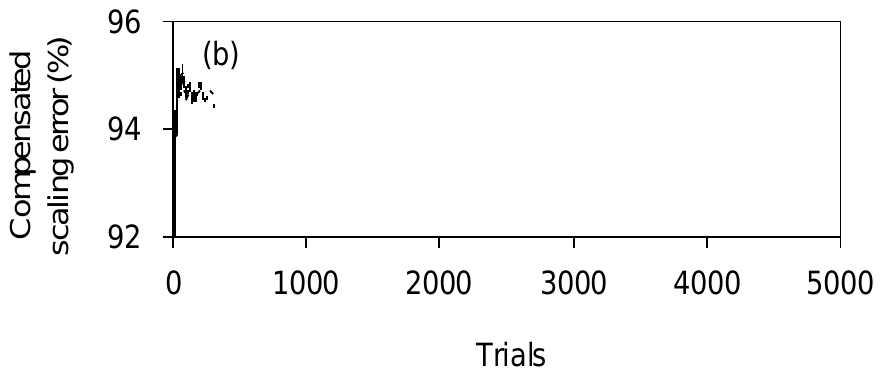
Figure 2. The efficiency of scaling error compensator based on statistic simulation. ( a ) Comparison between true value and modelled value of total amount of forest biomass in the pseudo region consisting of 100 stands ( n = 100). ( b ) Percentage of compensated scaling error depending on trials. It becomes convergent after trials approach 4000 times. Note: the curve indicates the compensated scaling error in percentage, which is averaged from the trials.